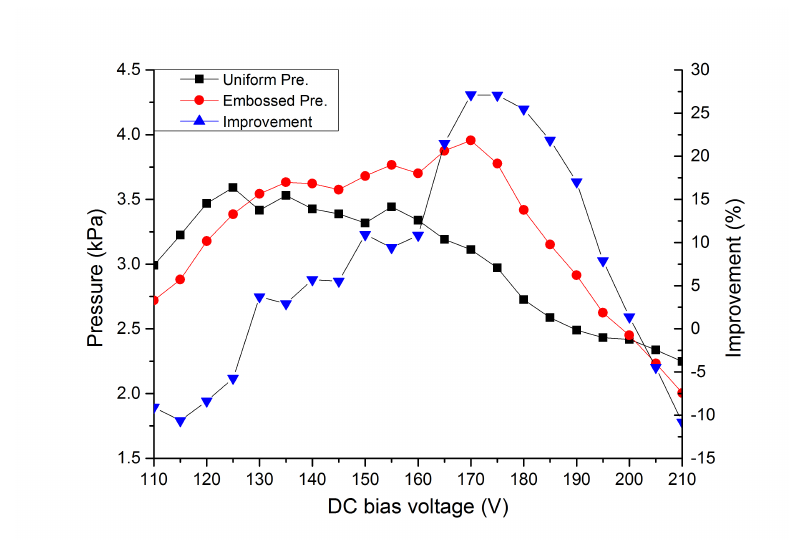
Figure 9. Output pressures of the uniform/embossed CMUT cells and the improvement of the embossed CMUT over uniform CMUT under different DC bias